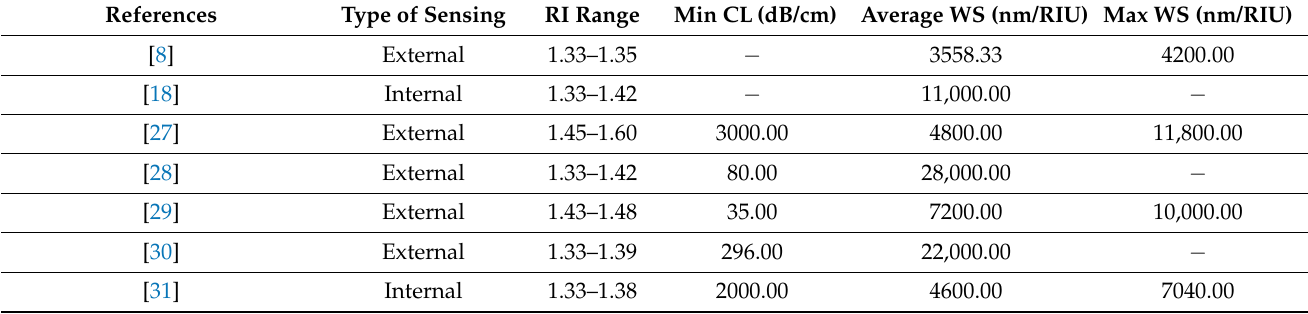
Y ( X ) = 9.6532 × 10 10 − 4.2282 × 10 11 X + 7.7154 × 10 11 X 2 − 7.5074 × 10 11 X 3 + 4.1084 × 10 11 X 4 − 1.1989 × Figure 11e 10 11 X 5 + 1.4575 × 10 10 X 6